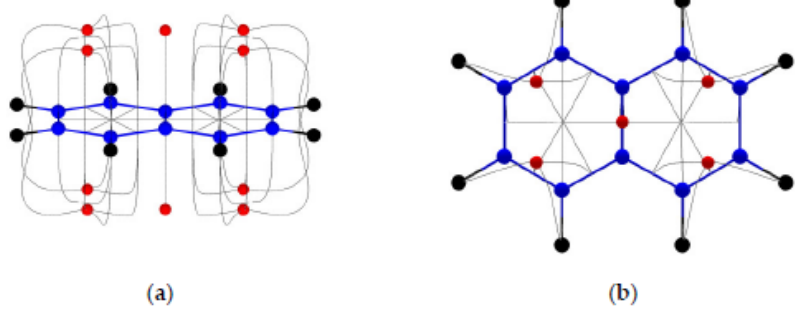
Figure 10. MESP topography of naphthalene molecule, calculated using B3LYP/6-311+G(d, p) level theory. ( a ) Side view and ( b ) top view of (3, +3) CPs (shown by red dots) embedded in gradient paths shown by grey curves. Red dots are MESP minima. See text for